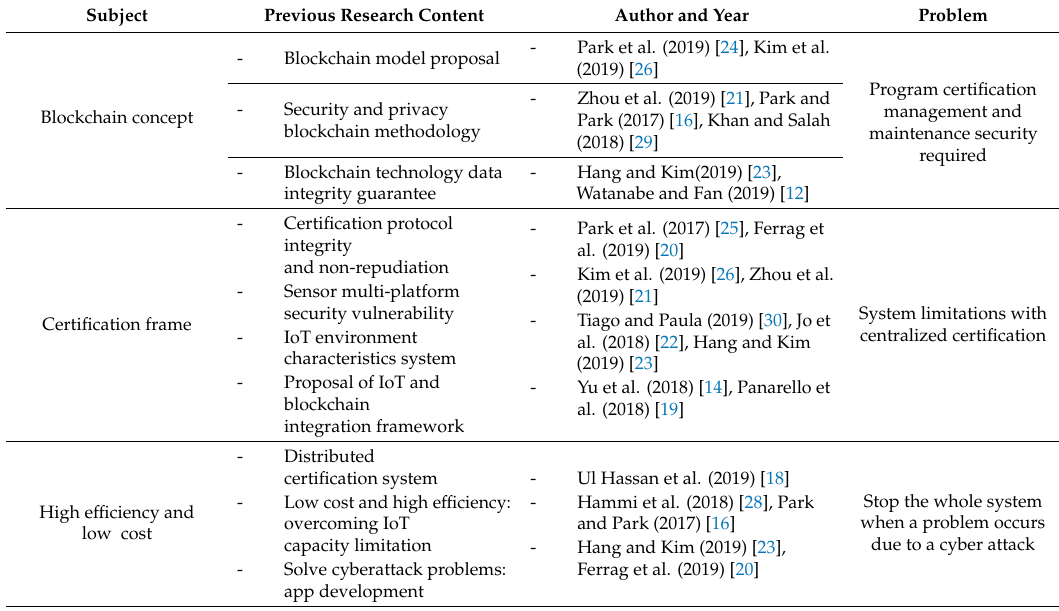
Table 2. Summary of previous research on blockchain and Internet of Things (IoT) certification